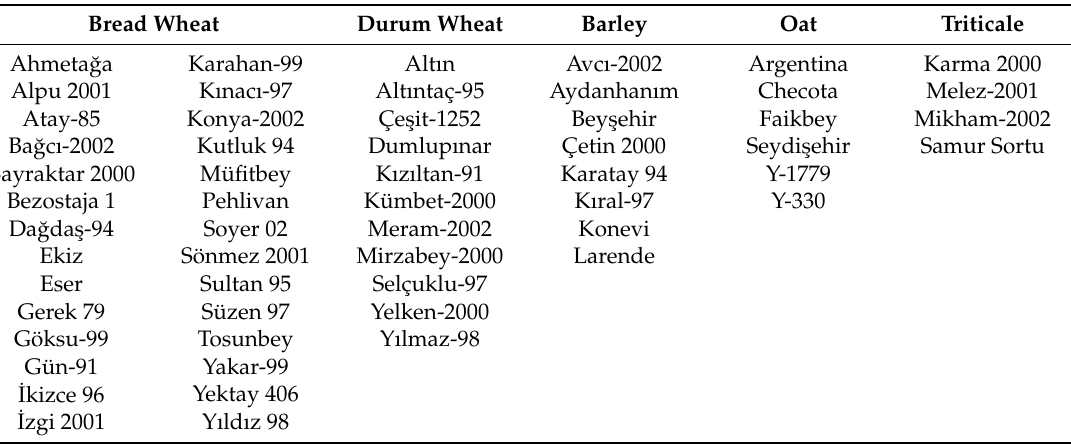
Table 1. Varieties used in the